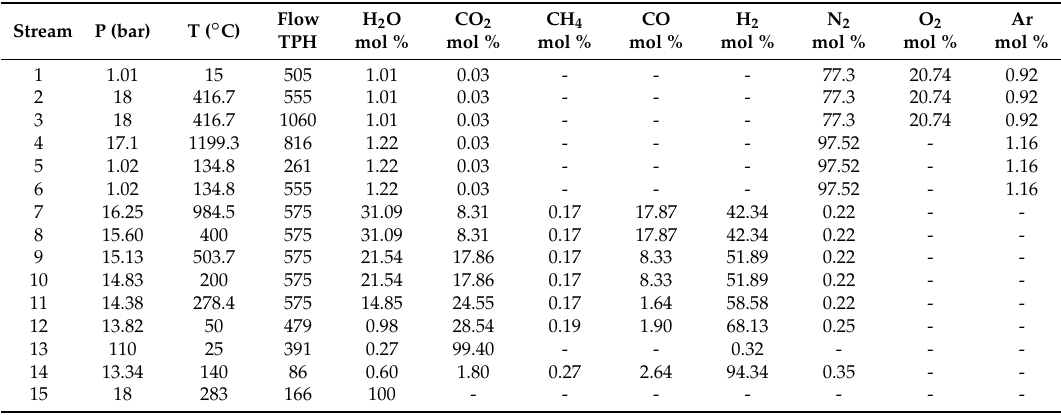
Table 2. Process stream data for the base case (P 18 ).